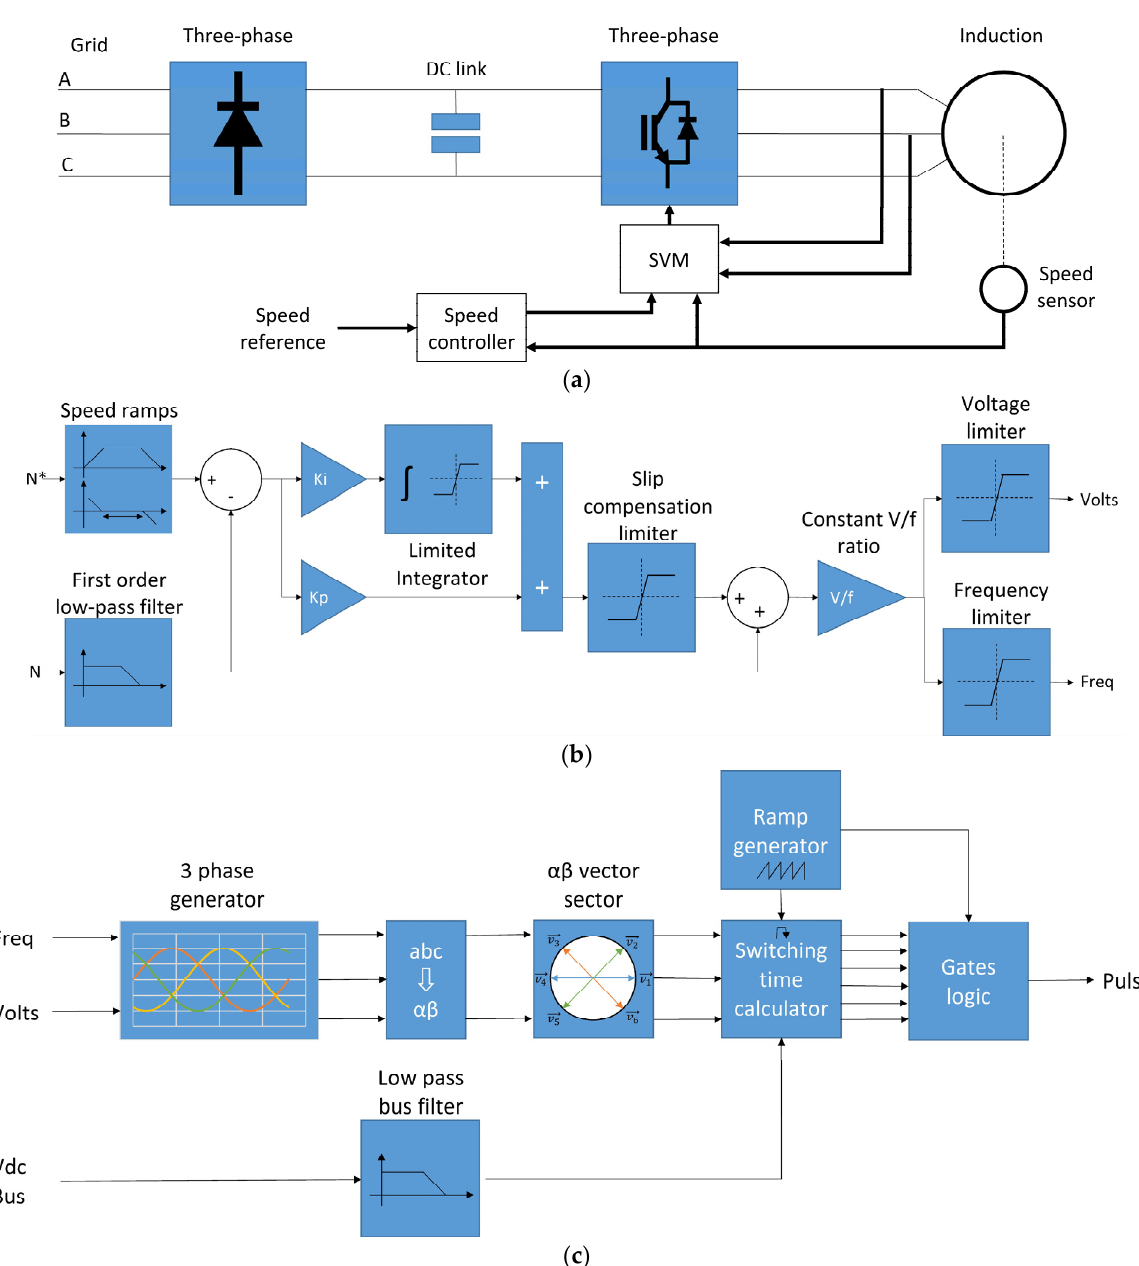
Figure 10. Block diagram of the Drive AC2 model in Simulink: ( a ) general power and control system diagram; ( b ) speed controller; ( c ) space vector modulation (SVM).